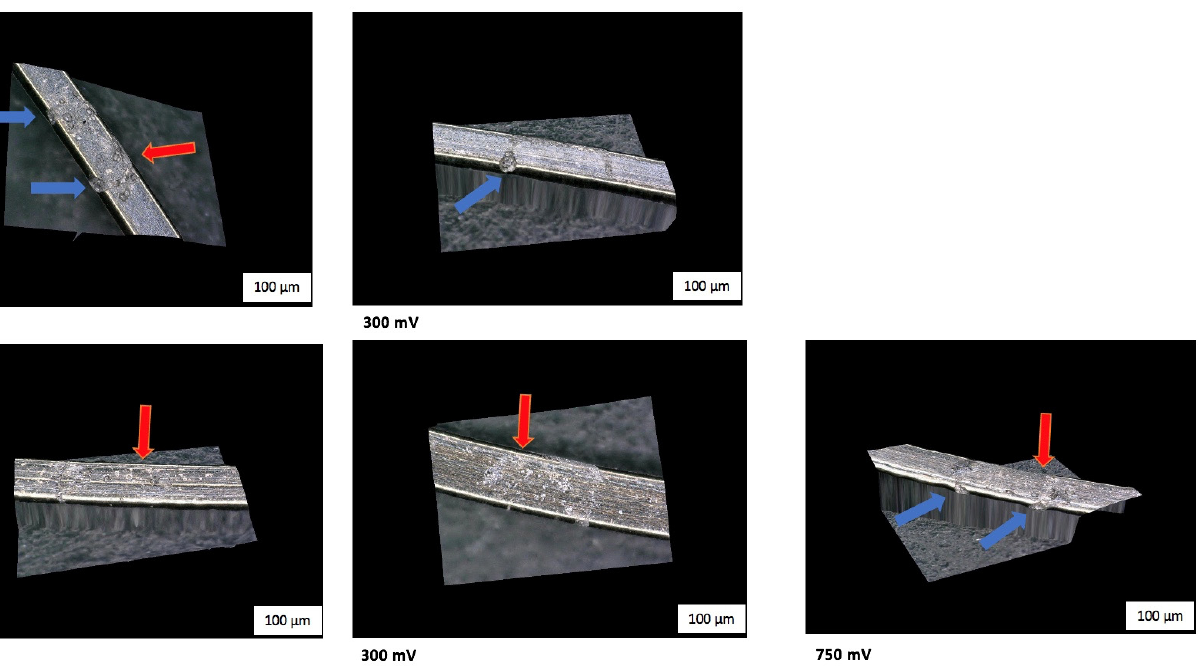
Figure 14. 3D microscopic pictures of the Ni–Ti wire surfaces after polarization in Ringer’s solution pH = 1 at RT. The applied potential is provided underneath each image; red arrows show some examples of pitting corrosion; areas marked in blue show crevice corrosion.